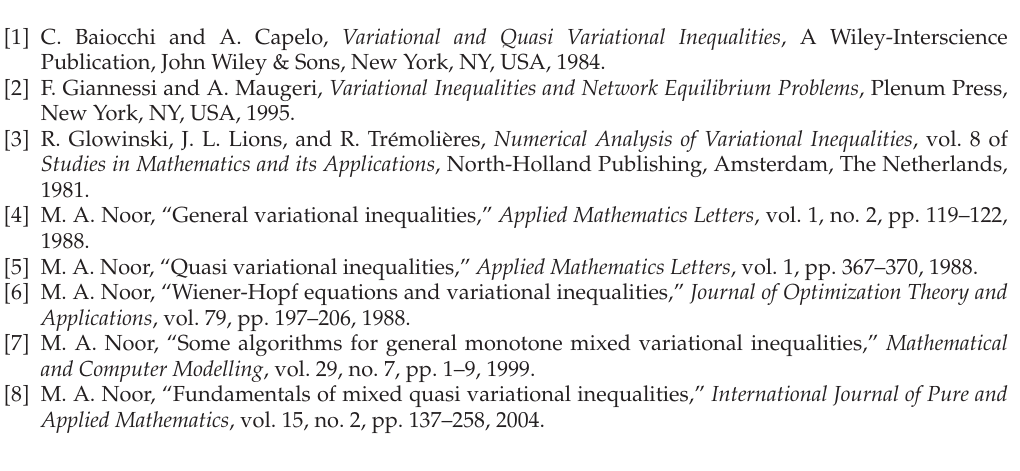
Algorithm 3.2. For a given u 0 ∈ H , find the approximate solution u n (cid:7) 1 by the iterative